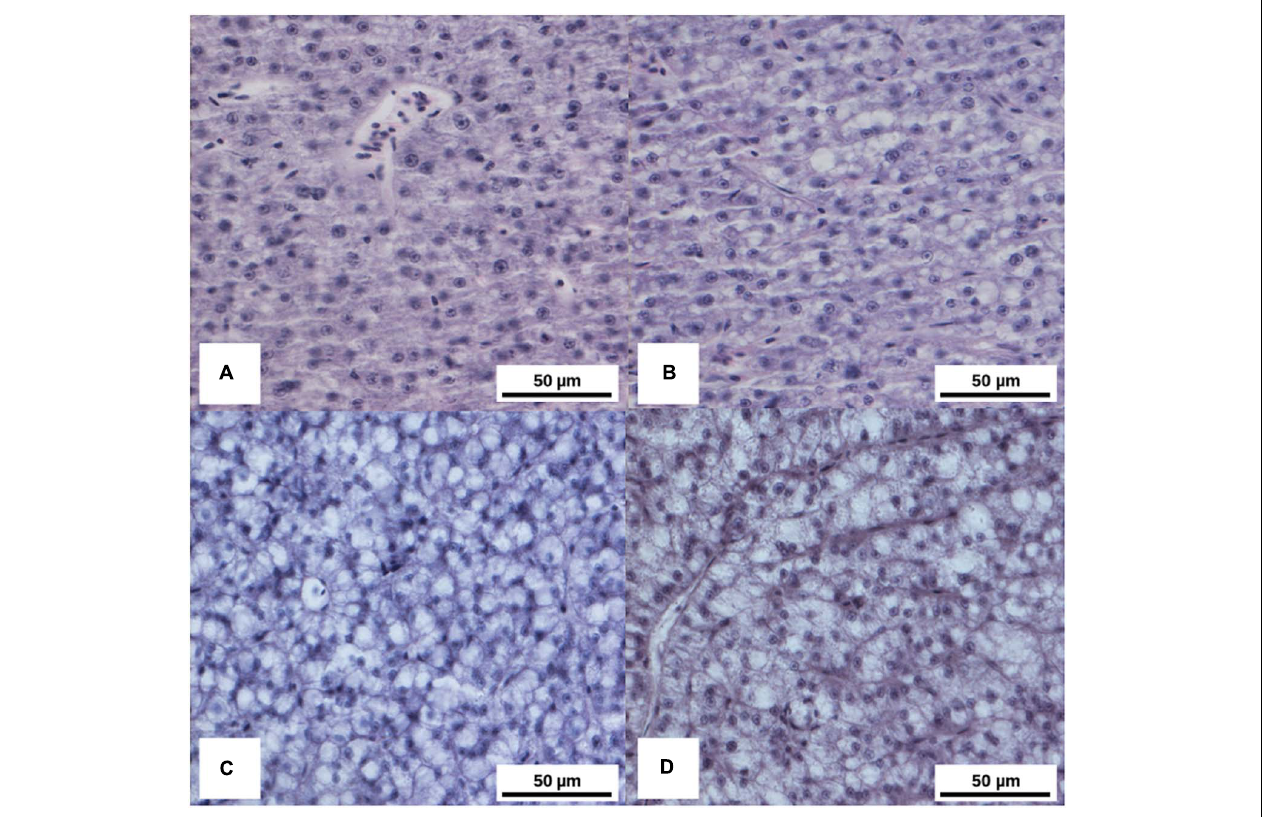
FIGURE 2 | Histopathological alteration of liver of pikeperch considered in the present study. (A) Normal liver, Haematoxylin & Eosin (H-e) stain, 40 × magnification, for HI36 diet. (B) Mild and multifocal vacuolar degeneration (grade 1), H-e, 40 × magnification, for HI18 diet. (C) Moderate and multifocal vacuolar degeneration (grade 2), H-e, 40 × magnification, for the HI9 diet. (D) Severe and diffuse vacuolar degeneration (grade 3), H-e, 40 × magnification, for CO